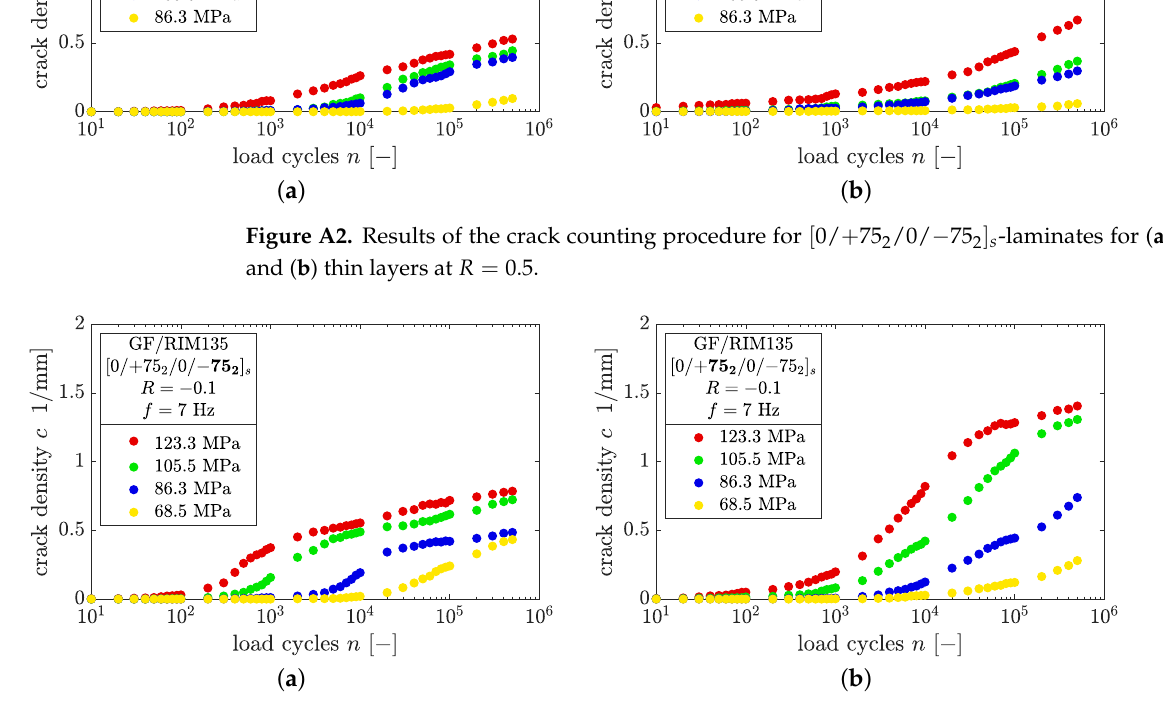
Figure A3. Results of the crack counting procedure for [ 0/ + 75 2 /0/ − 75 2 ] s -laminates for ( a ) thick and ( b ) thin layers at R = −